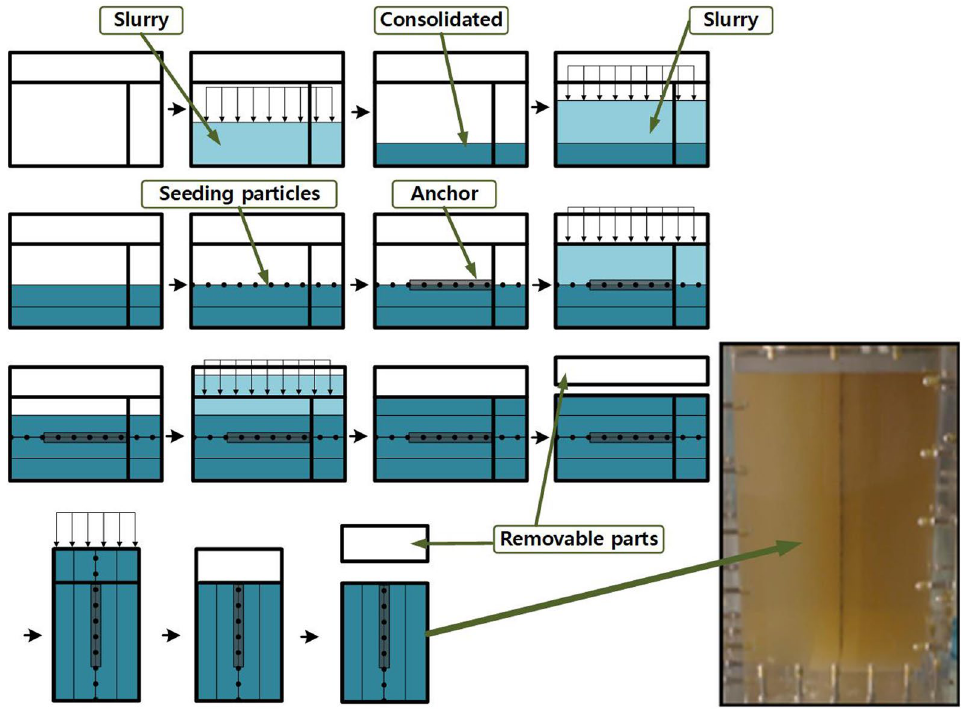
Figure 1. Transparent soil consolidation.